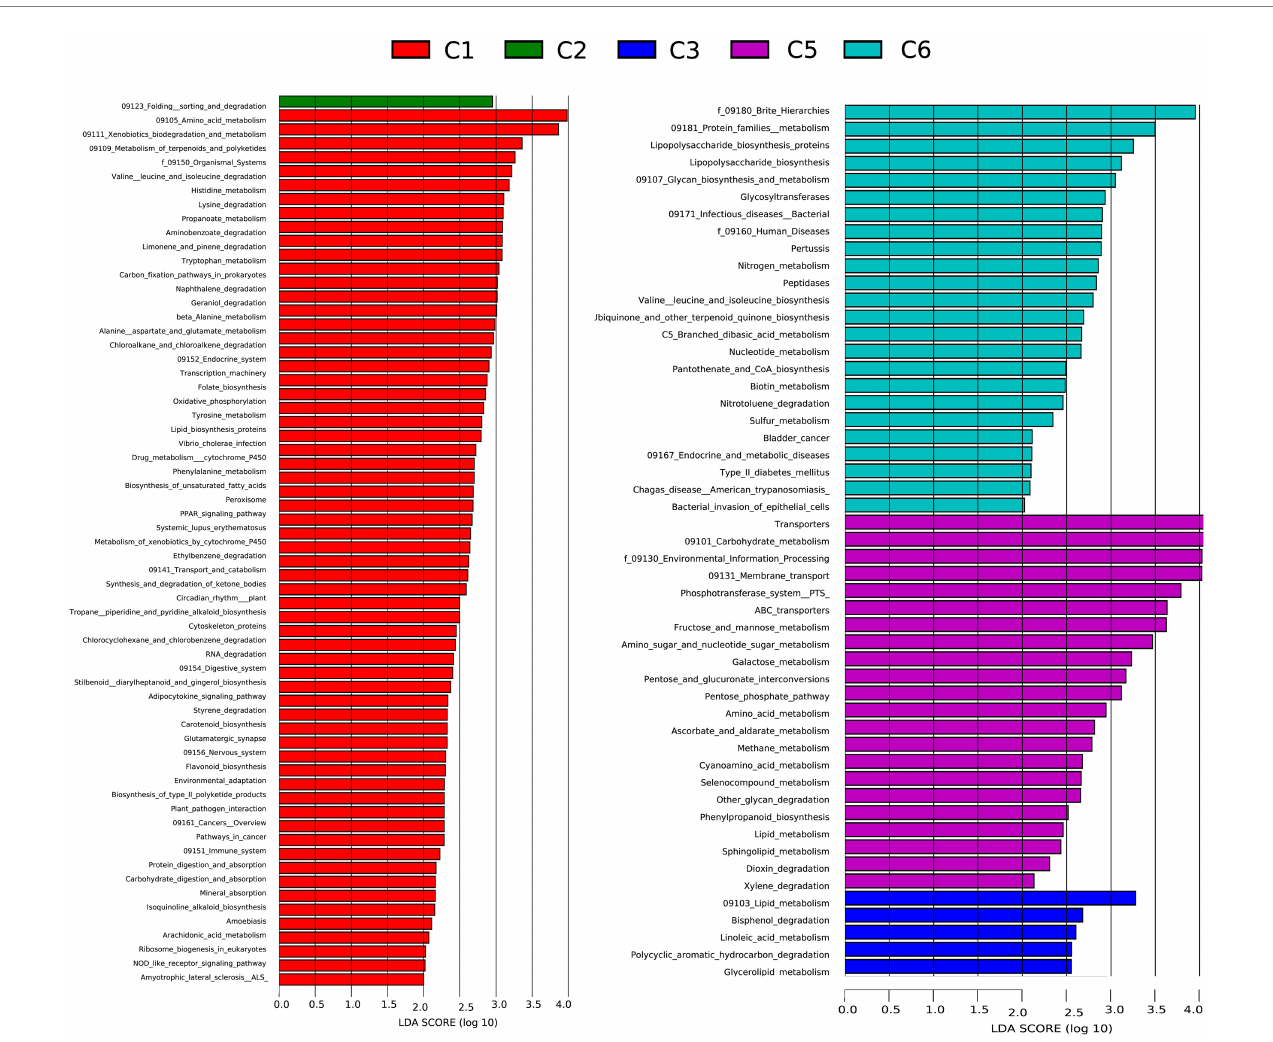
FIGURE 6 Comparison of relative abundance of functional modules among preterm infants at 6 time points C1, C2, C3, C5, and C6 (1, 7, 14,21, 28, and 42 days after birth) groups using Linear discriminant analysis effect size (LEfSe) analysis generated from PICRUSt. A number of 35, 1, 5, 18, and 15 KEGG modules are significantly enriched in C, C2, C3, C4, and C6, respectively. Data show differences in predicted bacterial metabolic function among all groups. Pathways with significant difference have an LDA score >